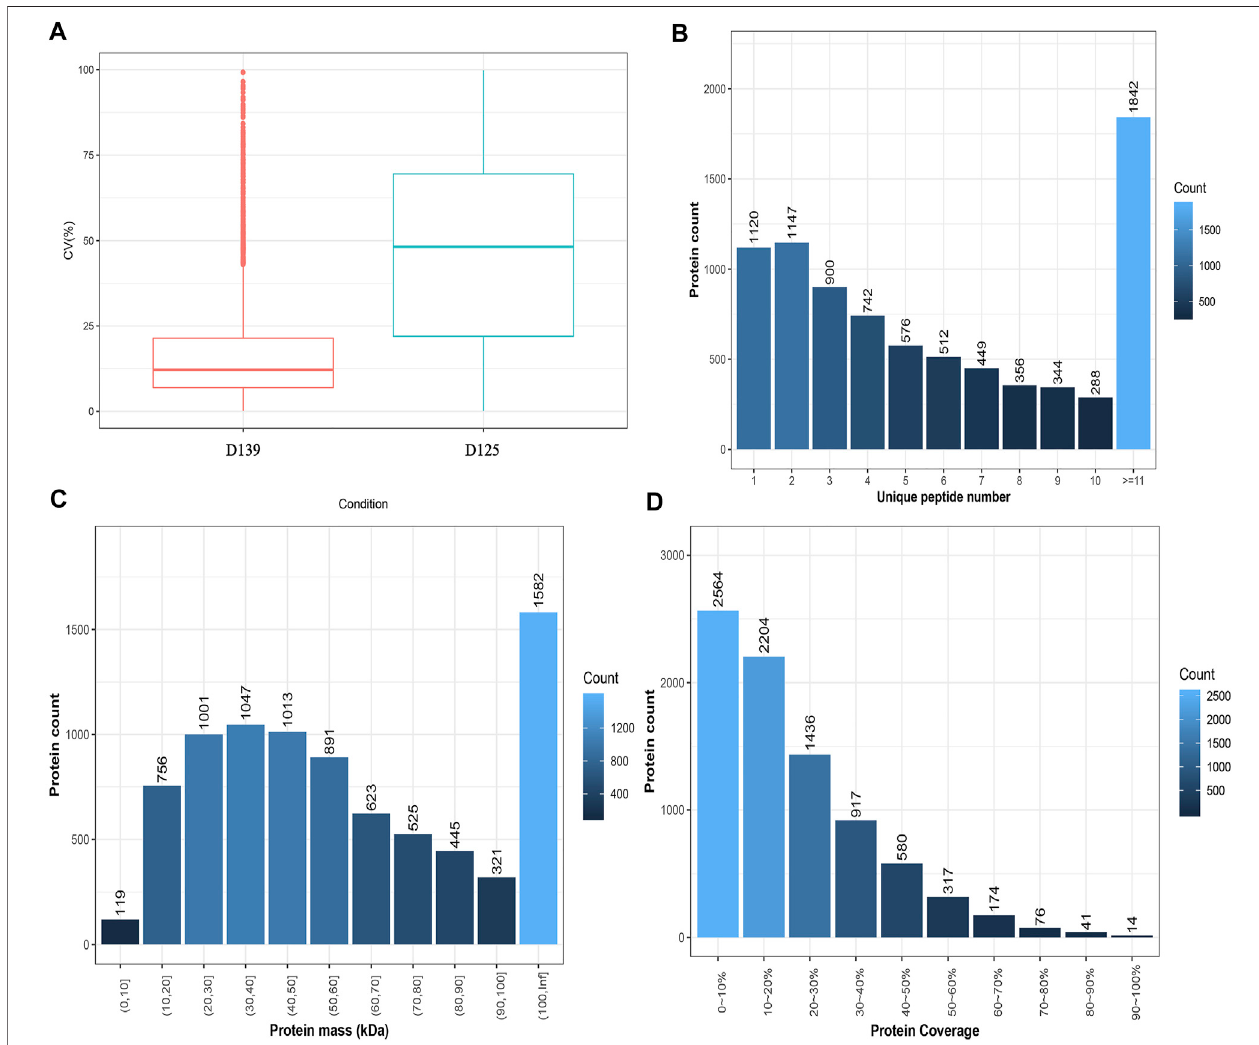
FIGURE 2 | Characterization of peptides and proteins identi fi ed by DDA database. (A) The intra-group CV distribution of different sample groups. The X -axis denotes the sample group and the Y -axis denotes the corresponding CV. (B) Unique peptide distribution. The X -axis is the number of unique peptides for each protein, andthe Y -axisisthenumberofproteins. (C) Proteinmassdistribution.The X -axisisproteinmassinterval(Kilodalton),andthe Y -axisisthenumberofproteins. (D) Protein coverage distribution. The X -axis is coverage percentage interval, and the Y -axis is the number of proteins.